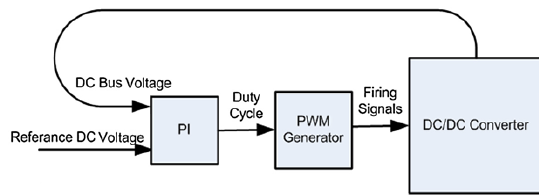
Figure 5. Control algorithm of DC–DC converter during V2H operation mode.